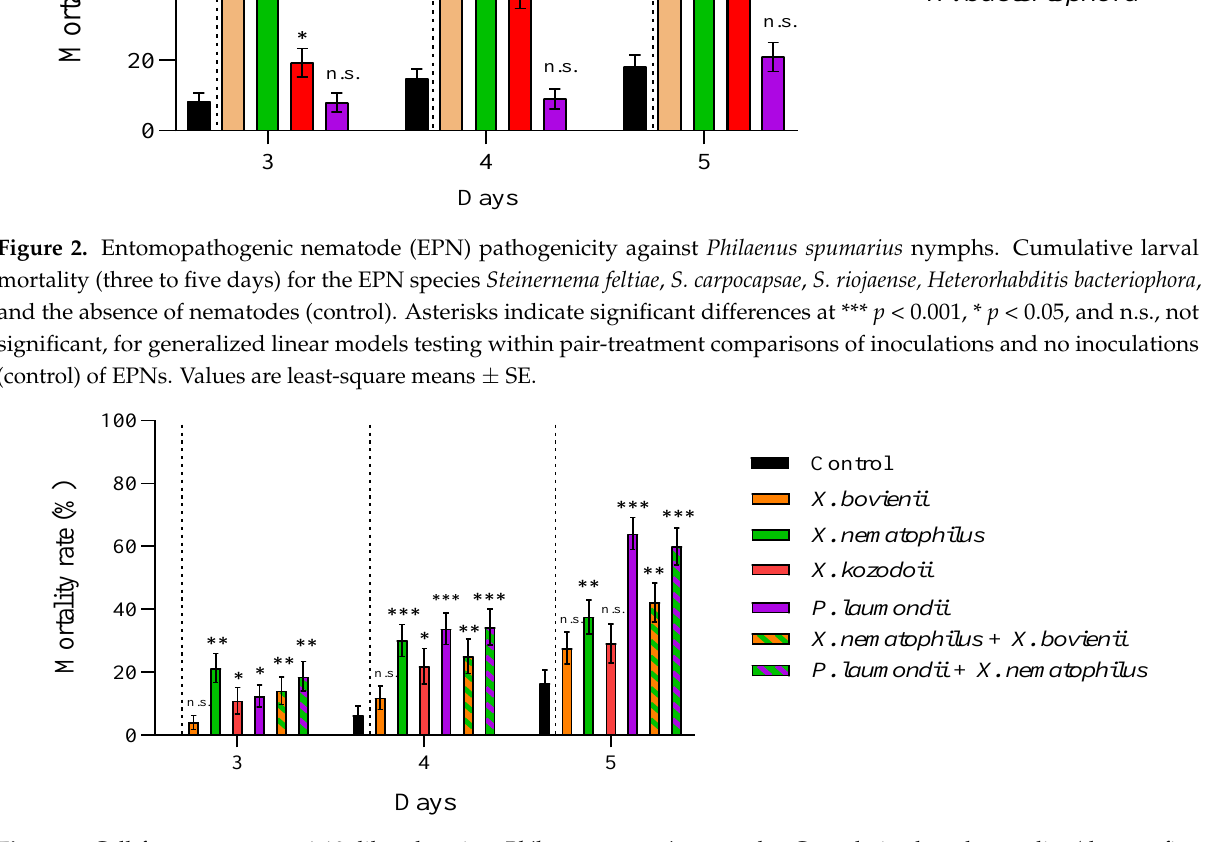
Figure 3. Cell-free supernatant 1:10 diluted against Philaenus spumarius nymphs. Cumulative larval mortality (three to five days) for the symbiont bacterial species Xenorhabdus bovienii , X. nematophilus X. kozodoii , Photorhabdus laumondii , and the combinations of X. nematophilus + X. bovienii and P. laumondii + X. nematophilus . Asterisks indicate significant differences at *** p < 0.001, ** p < 0.01, * p < 0.05, and n.s., not significant, for generalized linear models testing within pair-treatment comparisons of inoculation and no inoculation (control) of cell-free supernatants. Values are least-square means ± SE.